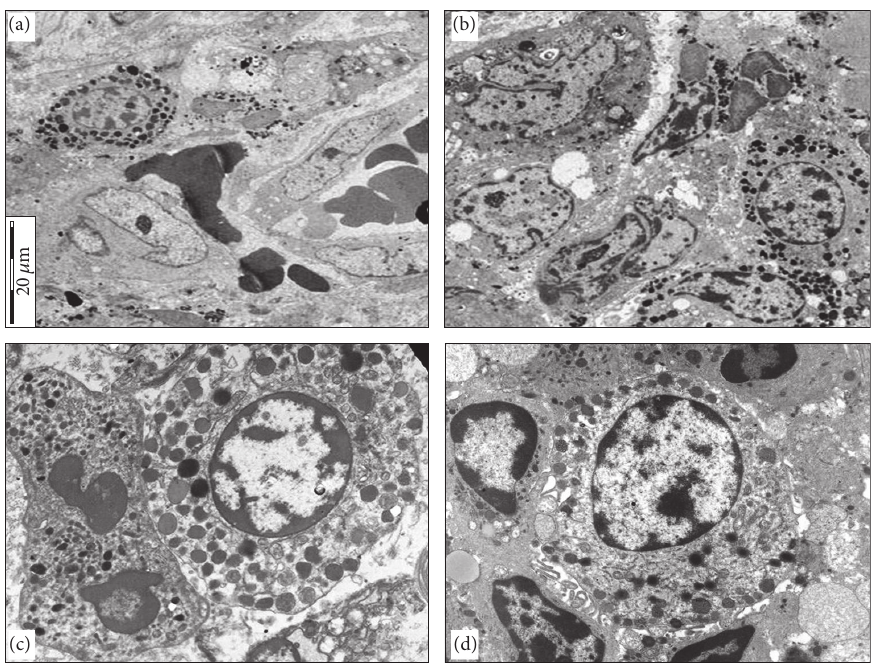
Figure 2: Mast cell showing a full complement of granules is in contact with a neutrophil, characterized by early apoptotic changes ((a), × 4000); another example of aggregation between mast cells and apoptotic neutrophils in the tumor stroma of a gastric adenocarcinoma ((b), × 4000); mast cell established pointed or flat areas of membrane contact with a neutrophil showing early apoptotic changes. Mast cell exhibits cytoplasmic microtubules, some of which are in close vicinity to granules ((c), × 10000); neutrophil satellitosis around mast cell showing peripheral location of granules and cytoplasmic microtubules. Some neutrophils show early apoptotic changes ((d), × 6000).